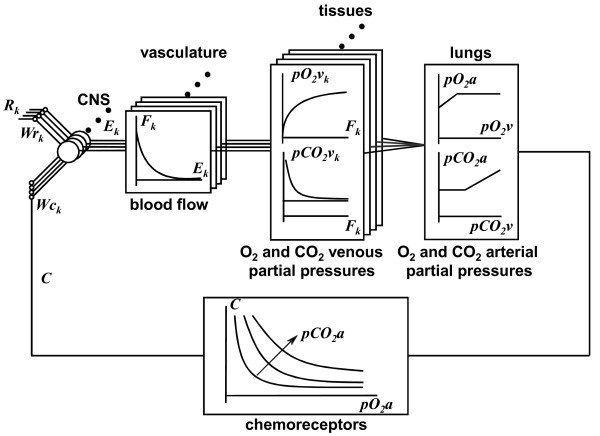
Neural network model of the simpathetic regulation. For each tissue (k), the sympathetic efferent discharge (Ek), the blood flow (Fk), the venous partial pressure of oxygen and carbon dioxide (pO2vk) and (pCO2vk), and the arterial partial pressure after the lung gases diffuse (pO2a) and (pCO2a) are shown. Finally chemoreceptors discharge (C) is depicted. Rk represents the rostral neural nuclei inputs from the NTS, and Wrk and Wck represent the synaptic weights.